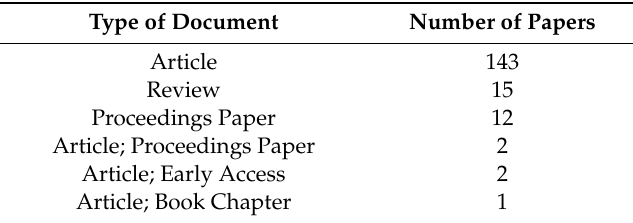
Table A6. Type of document